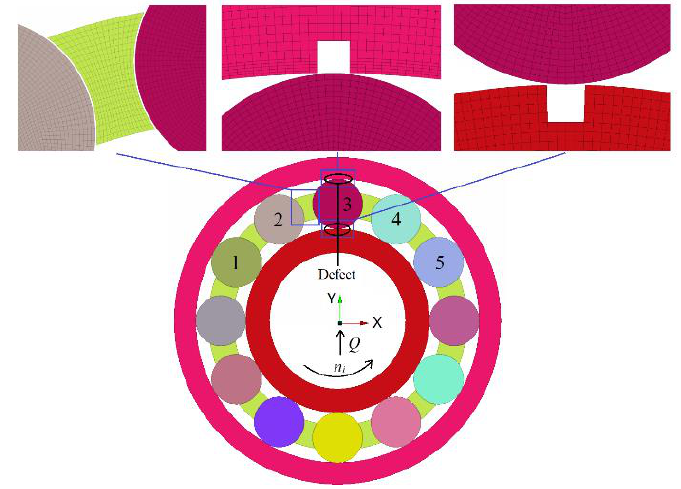
Figure 5. The FEM simulation model of NU306 bearing.